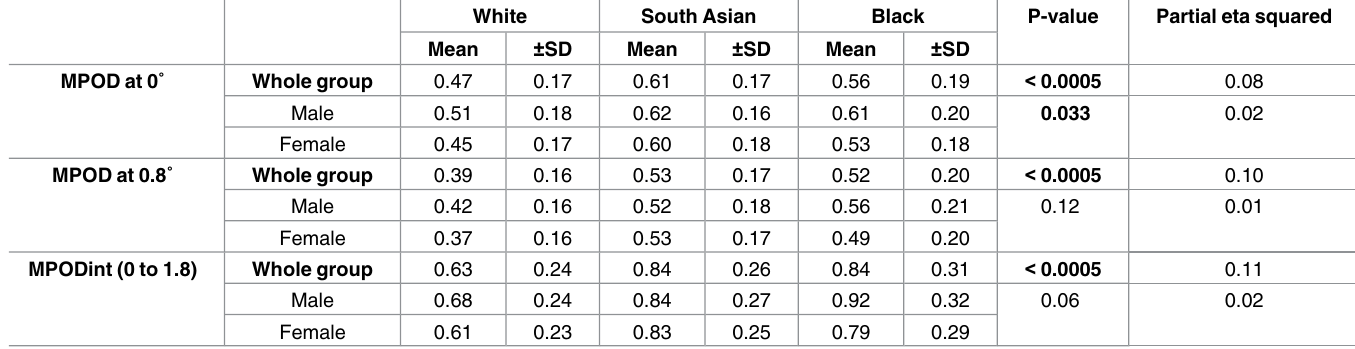
Table 1. Mean ± SD MPOD at 0˚, 0.8˚ and MPODint (0 to 1.8) per ethnic group and gender. Results of two-way analysisof covariancebetween-subjects effects of ethnicity are presented.